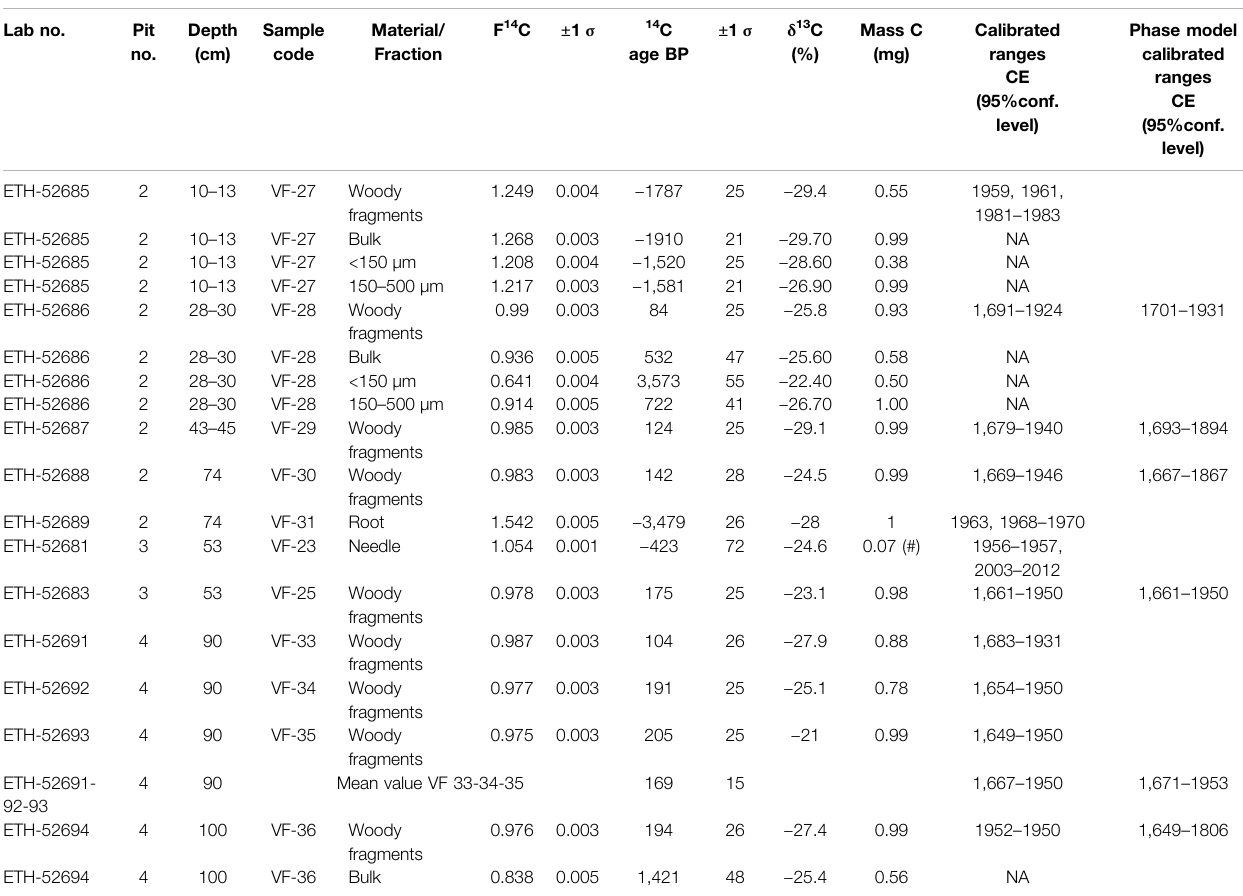
TABLE1| ResultsoftheAMSanalysisobtainedonsamplesselectedfromorganicrichlayersandonTotalOrganicCarbonTOCofvariousfractionsofsediments.F 14 Cisthe concentrationmeasuredinthesample,correctedforfractionationand normalized tothe1950value,andthecorresponding 14 Cage.The δ 13 Cvalueswasmeasuredon the graphite. The mass C is the fi nal carbon content of the sample. The fi rst sample contained only 70 µg of C (#) and was analyzed as CO 2 using gas ion source (GIS). Calendar ages corresponding to the measured F 14 C concentration. Calibration and a phase model was performed using the OxCal calibration with INTCAL13 calibration curve (Reimer et al., 2013). The postmodern ages were calibrated using the CALIBomb and with the data for the Northern Hemisphere (Hua et al., 2013; Levin et al., 2013). Lab no. Pit